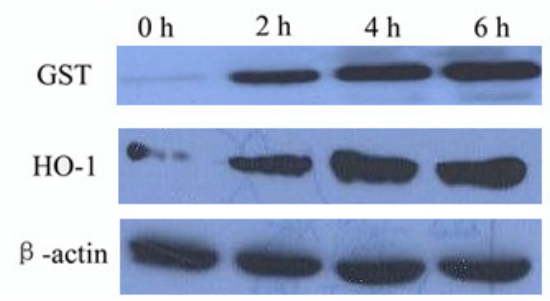
Figure 4. Icariside II (5 µ M) induced Nrf2-related antioxidant protein expression in HepG2 were assayed by Western blot